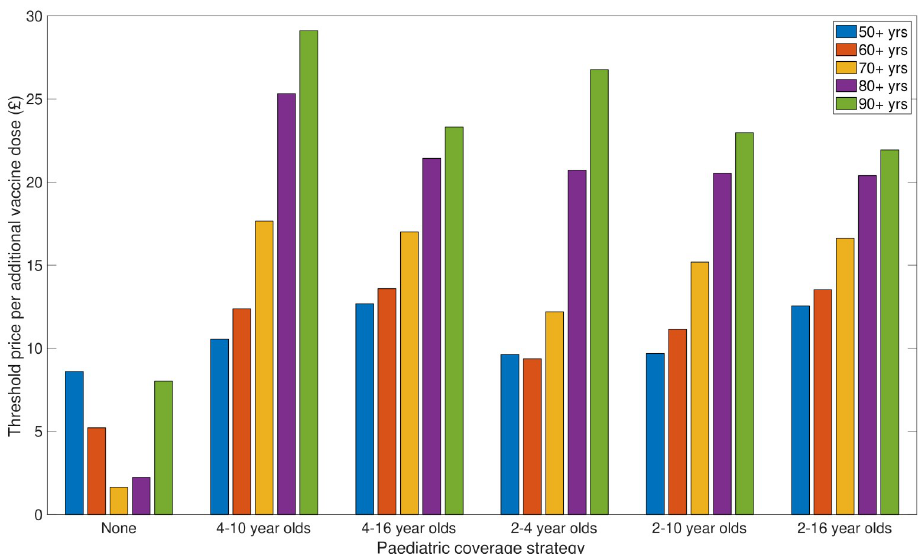
Fig 4. Threshold price per additional vaccine dose enabling low-risk uptake amongst paediatric and elder-age centric age groups to be deemed cost-effective. Threshold vaccine dose prices reflect the value at which the programme becomes cost-effectiveness at a WTP of £20,000 per QALY, with 3.5% discounting for monetary costs and health effects. In all considered strategies, we assumed 10% vaccine wastage and an administration fee per deployed vaccine of £10. In order of plotting group, the paediatric strategies covered the following age ranges: None, 4-10yrs (primary school only), 4-16yrs (primary and secondary school), 2-4yrs (pre-school only), 2-10yrs (pre-school and primary school aged children), and 2-16yrs (preschool, primary and secondary school). Per paediatric strategy, we considered five elder-age centric programmes, each having a varying breadth of age coverage: 50 years and above (blue bars), 60 years and above (orange bars), 70 years and above (yellow bars), 80 years and above (purple bars), 90 years and above (green bars). For full results, see S1